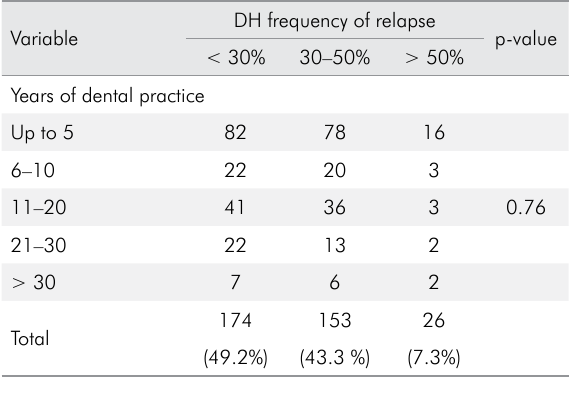
Table 2. Analysis between years of clinical practice and frequency of dentin hypersensitivity relapse after conclusion of treatment (n =